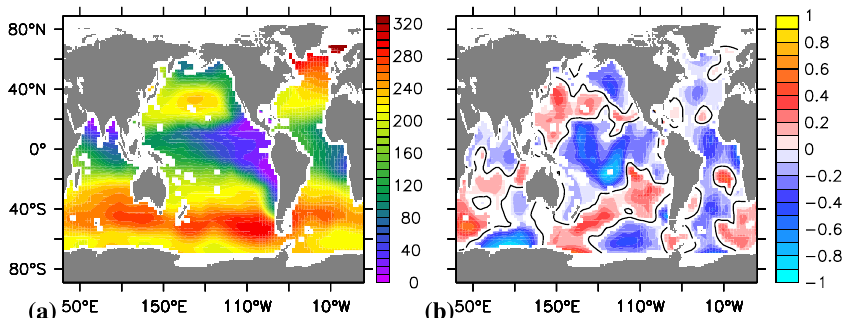
Fig. 2. Global mean dissolved oxygen (DO) distribution in µmolkg − 1 (a) at 300dbar and (b) DO changes at 300 dbar in µmolkg − 1 yr − 1 for the period 1960 to 2010. In (b) areas with DO increase are red and decreases blue and areas with DO changes below the 95% confidence standard error interval are